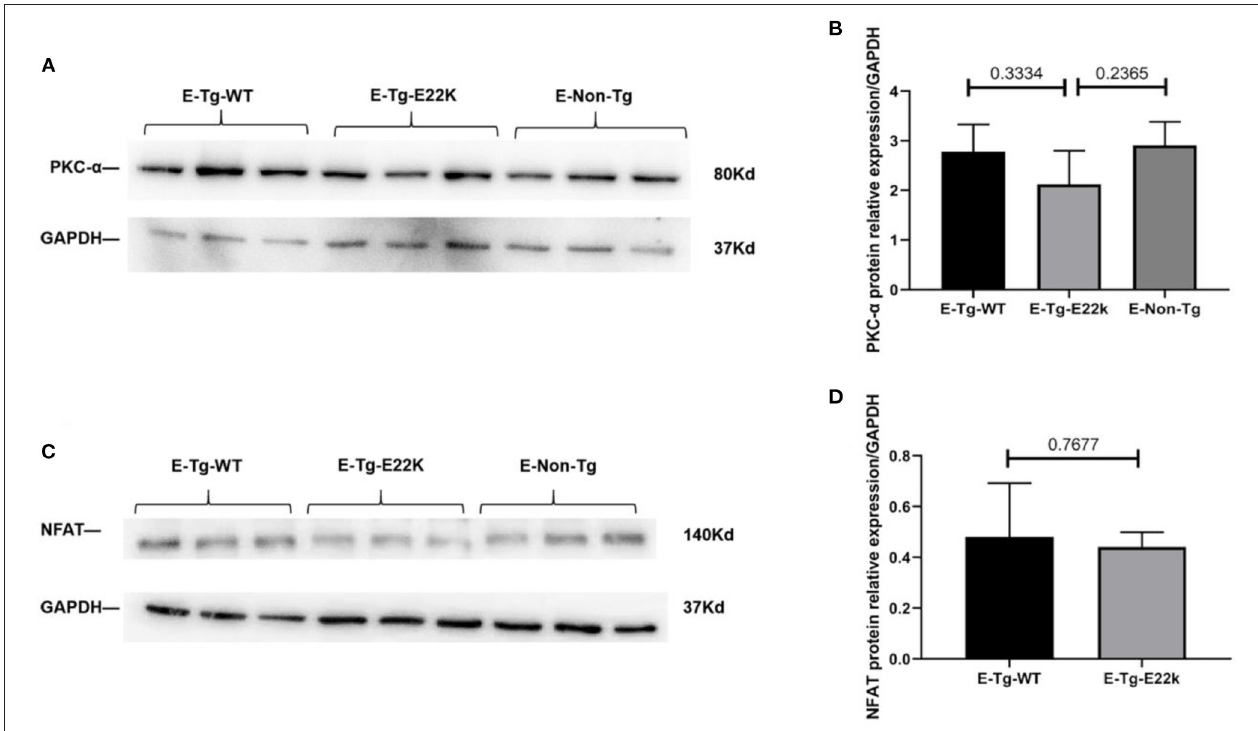
FIGURE 5 | Exercise changes the protein expression of PKC- α /NFAT. Representative Western blot results show that there are no remarkable differences in the expression levels of PKC- α and NFAT between Tg-WT and exercise-trained E22K mice (A,C) . Densitometric analysis of the protein levels of PKC- α and NFAT in